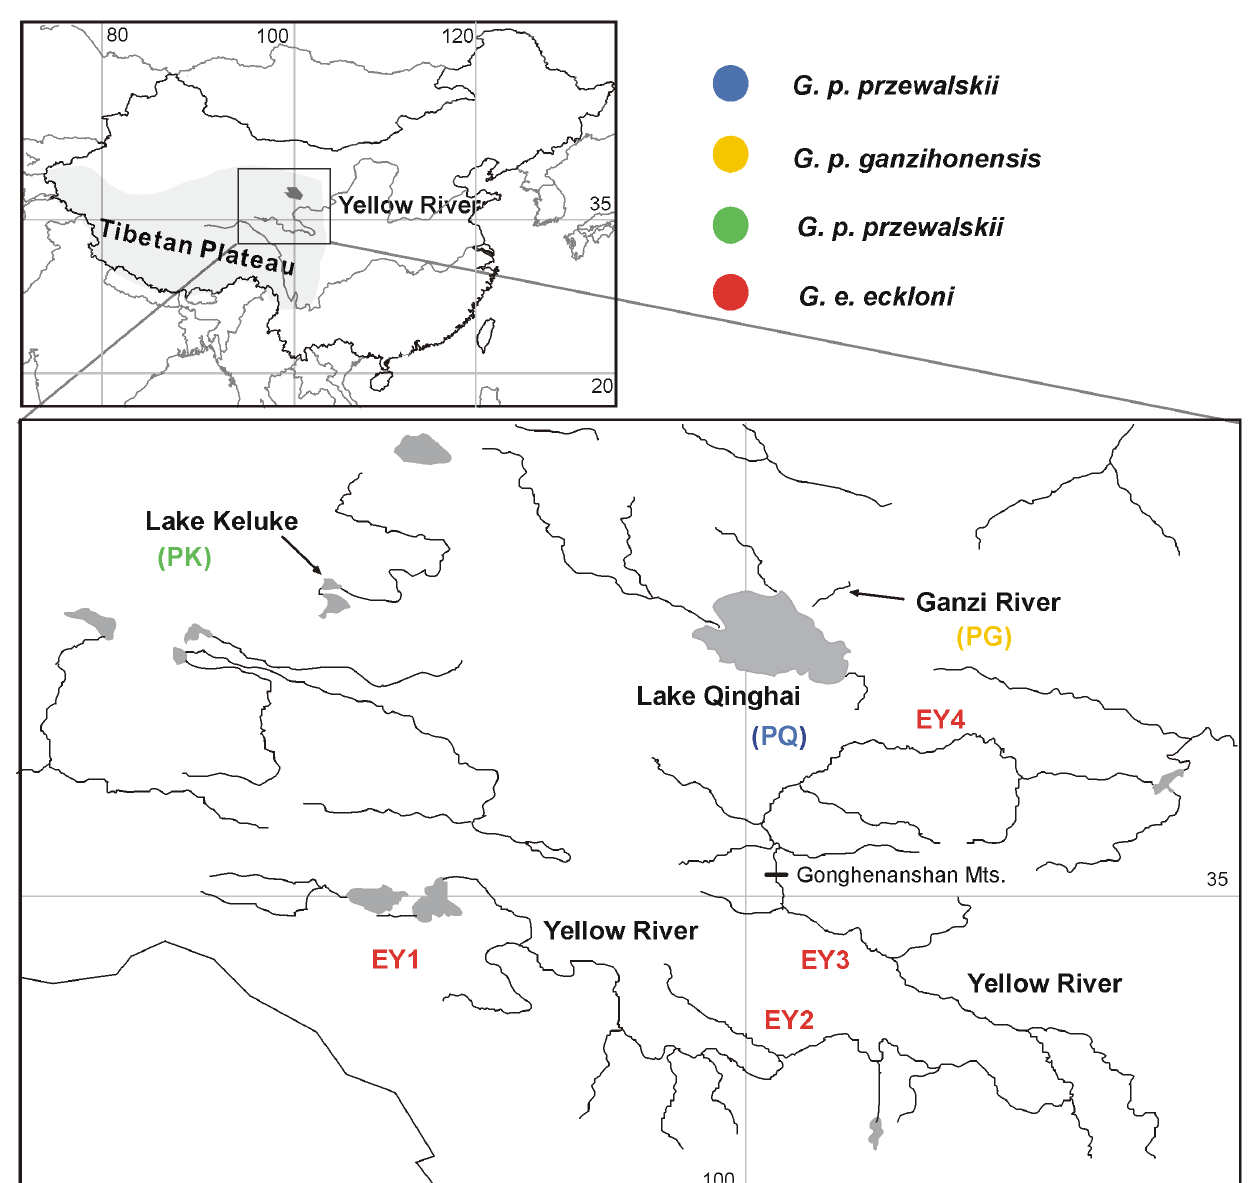
Figure 1. Geographic location of the Gymnocypris species complex. This map shows the locations of the samples in the Northeastern Tibetan Plateau and their corresponding codes, as listed in Table 1. species G. przewalskii (Fig. 1) [34–36], and a second, more